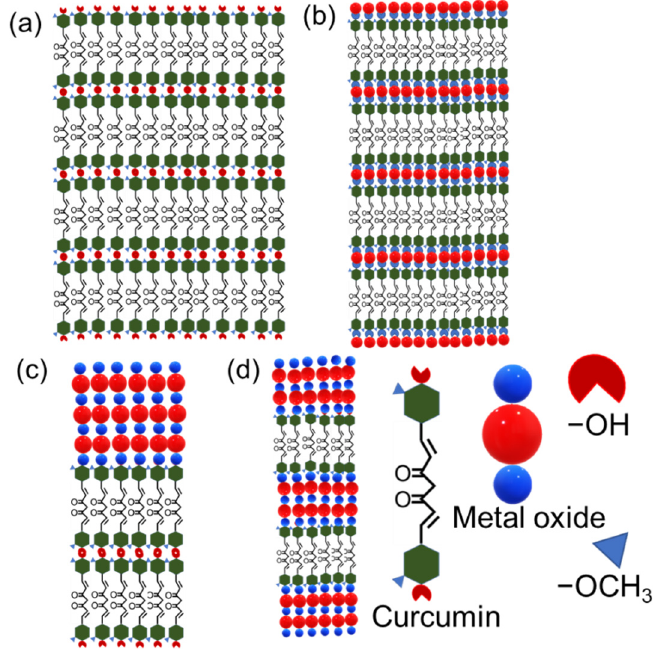
Figure 1. Thin-film structures deposited in this work: ( a ) Curcumin (Cur) films via S-C; ( b ) Metal- curcumin (Ti-Cur or Zn-Cur) films via ALD/MLD; ( c ) Curcumin plus metal oxide (Cur/ZnO or Cur/TiO 2 ) double-layer (DL) films via S-C and ALD, respectively; ( d ) Metal-oxide:Cur (ZnO:Cur or TiO 2 :Cur) superlattice (SL) films via ALD/MLD.